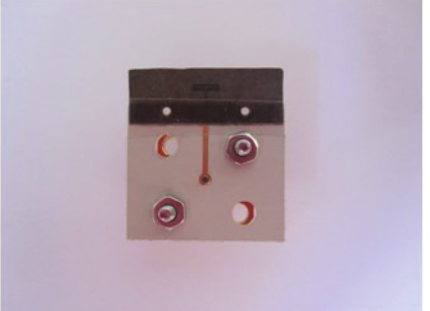
Figure 10: The back of the proposed antenna.